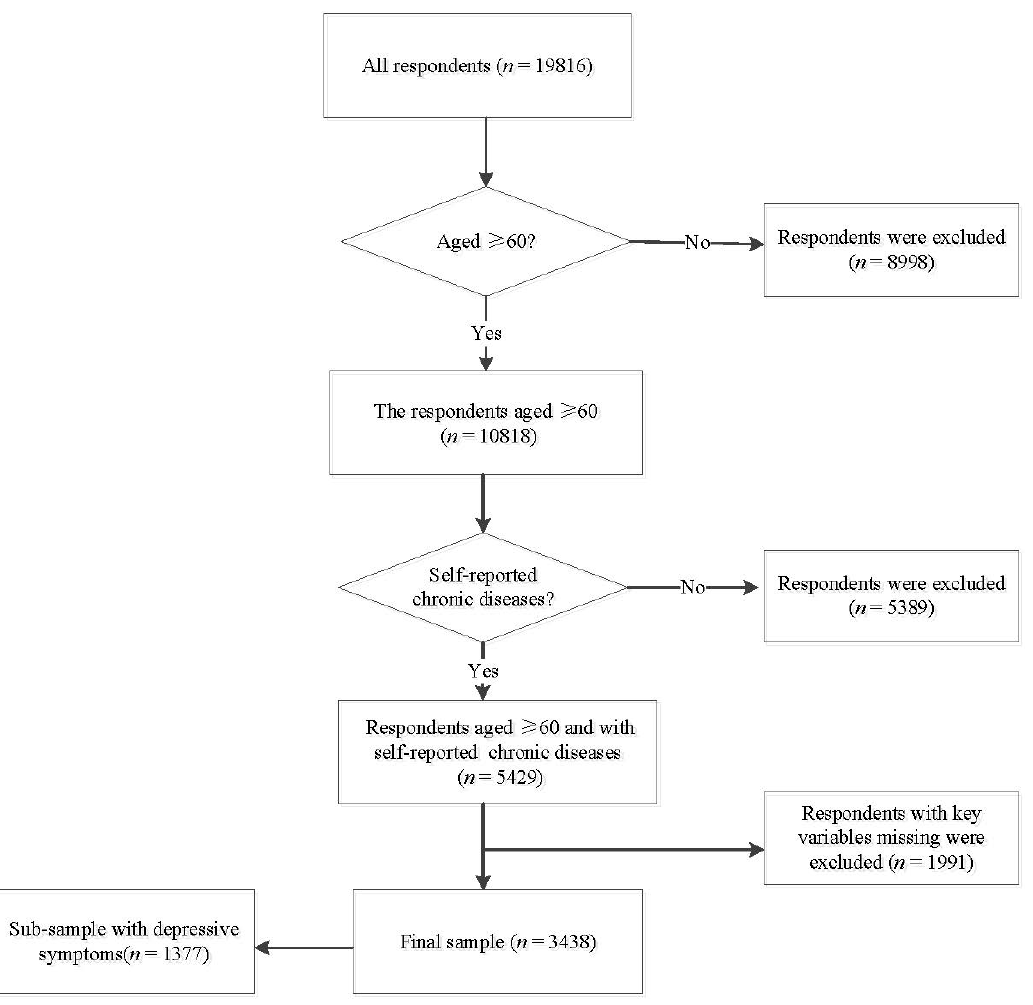
Figure 2. The flow diagram for sample screening.